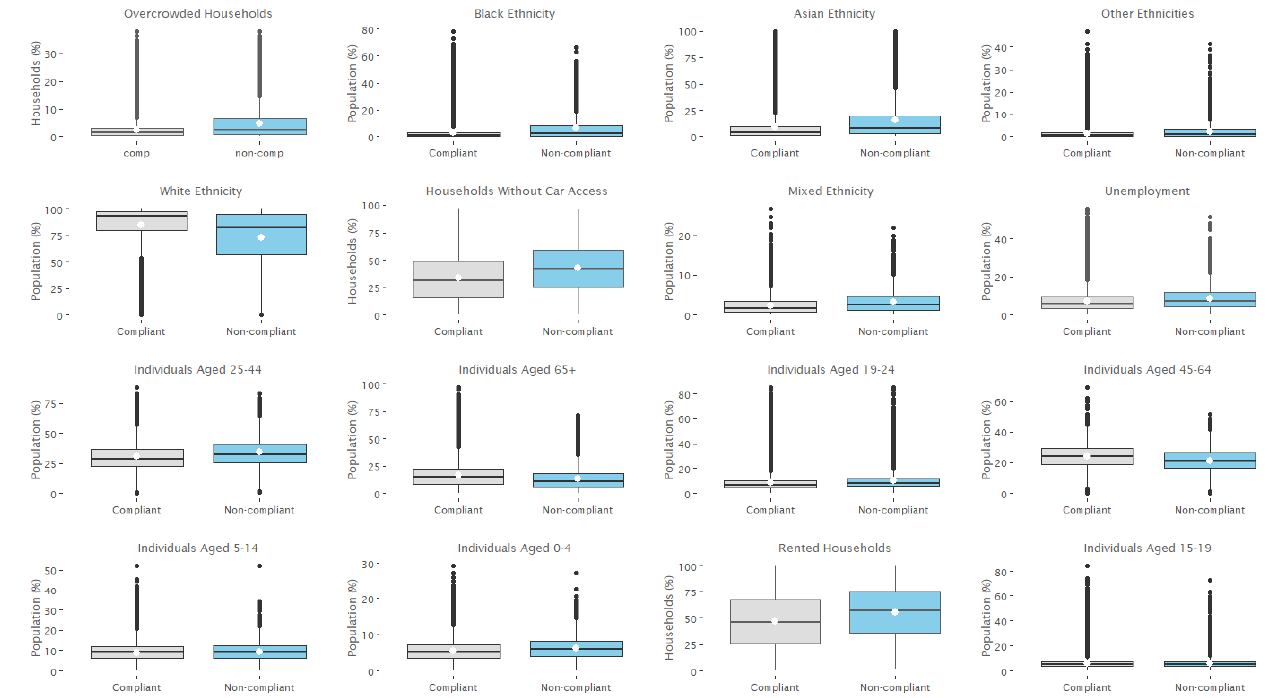
Figure 4. Boxplots for numeric predictor variables reported across the two